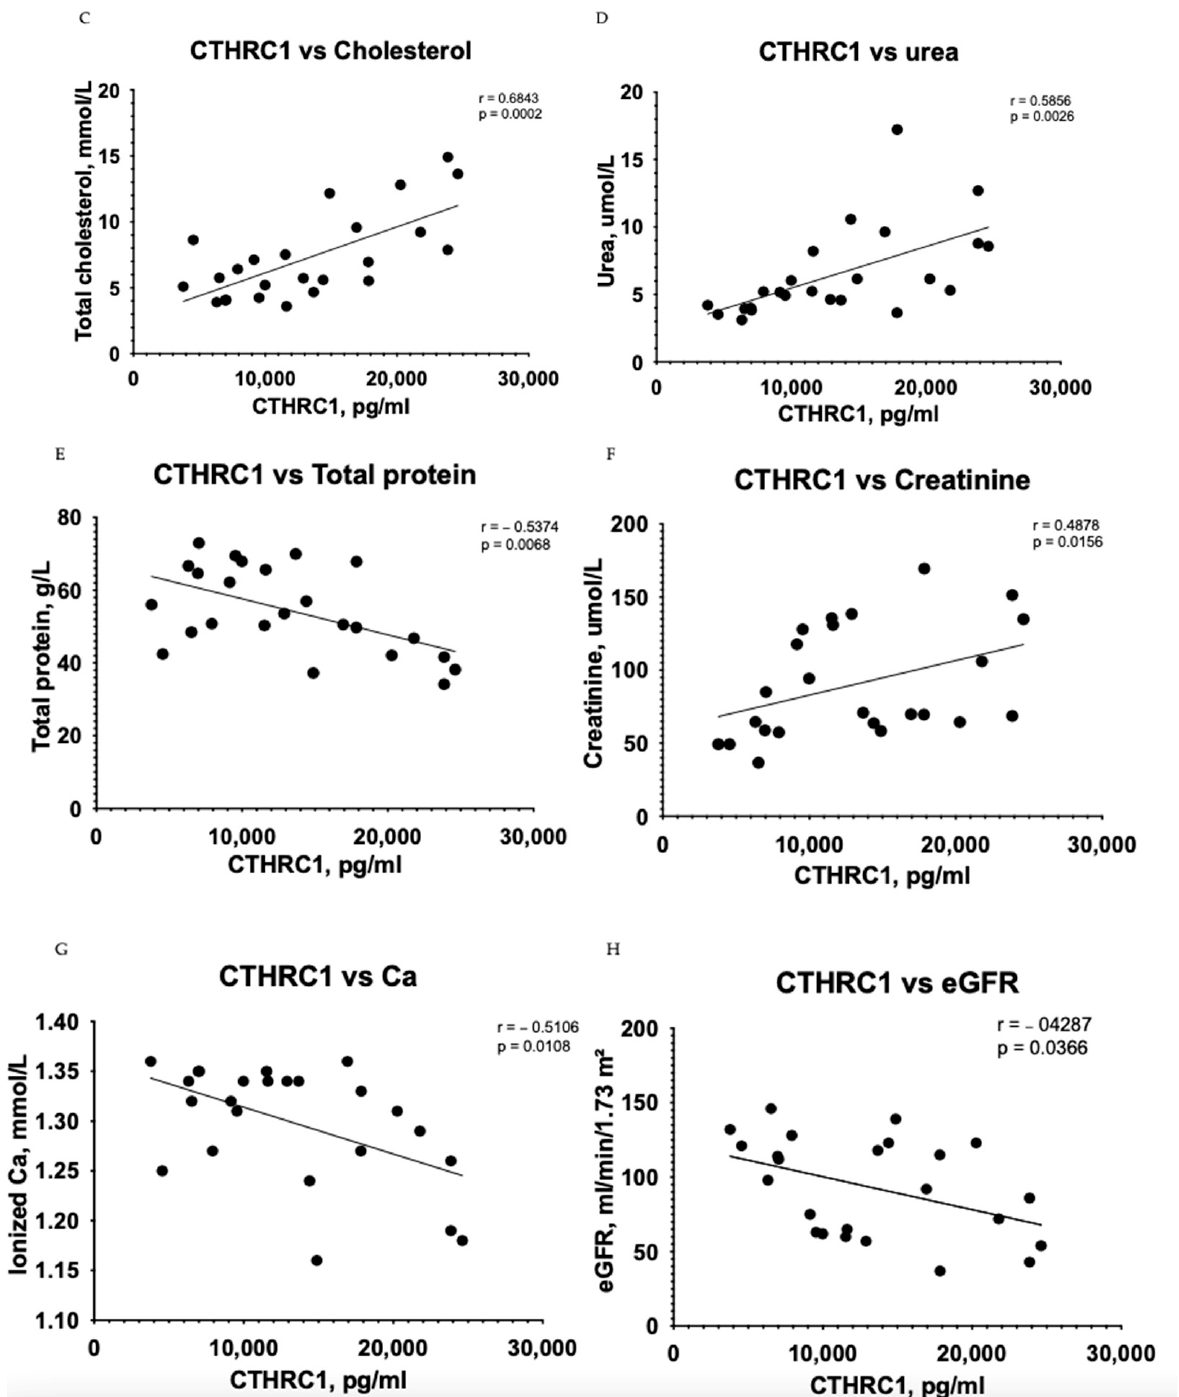
Figure 1. Correlation between plasma levels of CTHRC1 and notable clinical measures in CKD patients. The relationship between variables was evaluated using Pearson’s correlation test. Trend lines indicate linear correlation. Pearson’s (r) coefficient and the corresponding p -values are shown on each plot. Scatter plot graphs illustrating correlation between ( A ) CTHRC1 and uric acid, ( B ) CTHRC1 and total protein collected in 24 h in urine, ( C ) CTHRC1 and cholesterol, ( D ) CTHRC1 and urea, ( E ) CTHRC1 and plasma total protein levels, ( F ) CTHRC1 and creatinine (CTHRC1 and creatinine parameters were analyzed via Spearman’s rank correlation test), ( G ) CTHRC1 and ionized calcium levels, ( H ) CTHRC1 and eGFR.